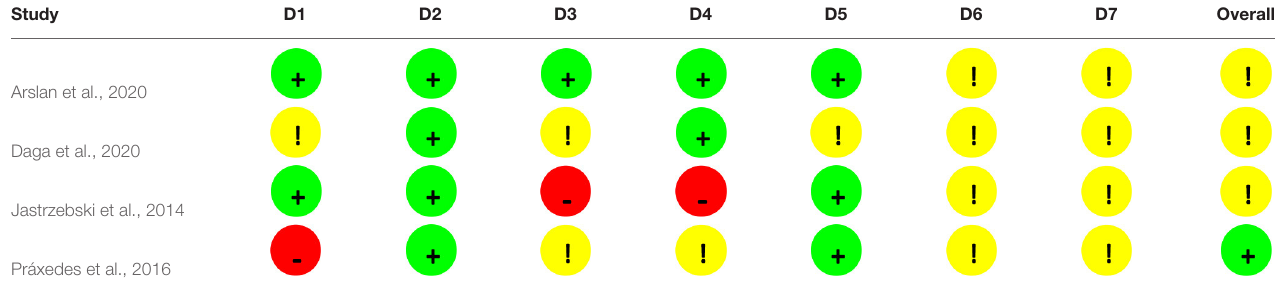
TABLE 3 | Assessment of risk of bias of non-randomized trials with ROBINS-I. Study D1 D2 D3